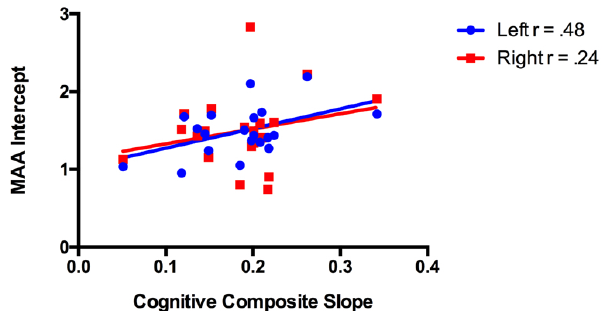
Figure 13. Scatter plot of normalized area of acceleration intercepts (for right and left arms) and Bayley composite motor intercepts of each infant.